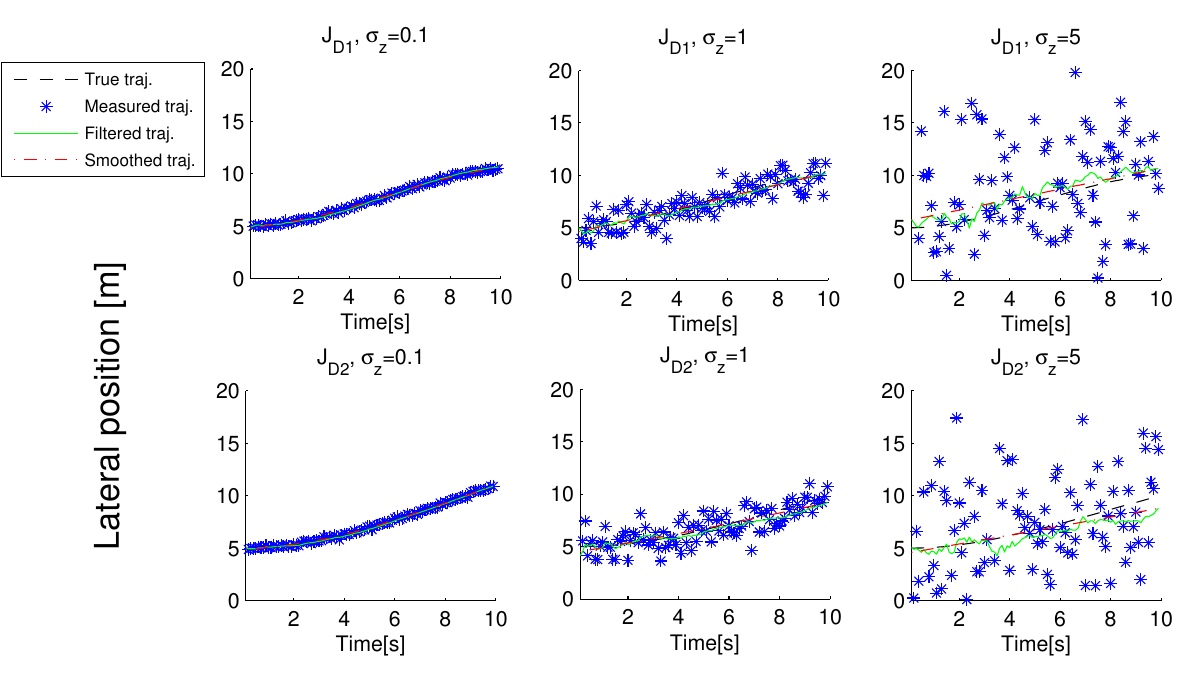
Figure 11. Kalman filter effect on trajectories for J ∈ { 0 . 1 , 1 , 5 } ( σ z